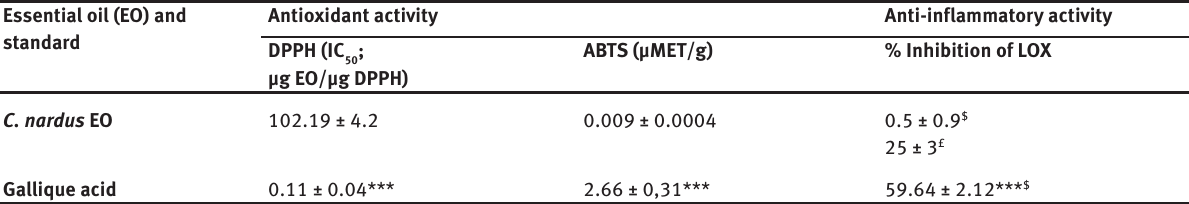
Figure 3: Percent inhibition of the DPPH radicals of Cymbopogon nardus essential oil as a function of Table 2: Antioxidant and anti-inflammatory activity of C. nardus essential oil and gallique acid.